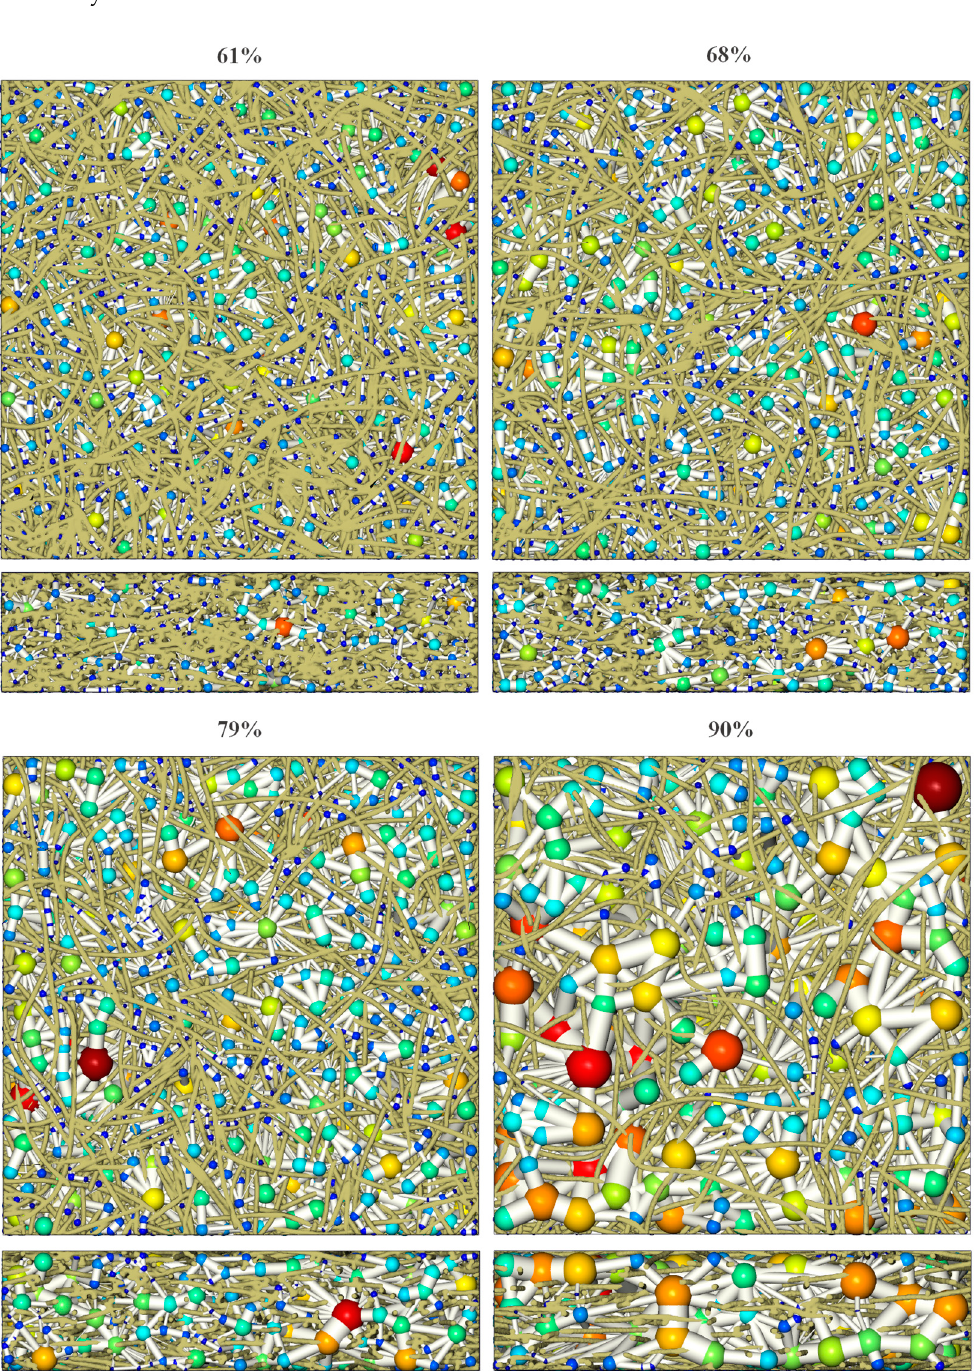
Figure 3. Pore network modeling (PNM) of 61%, 68%, 79%, and 90% porosity porous metal fiber sintered sheet (PMFSS).